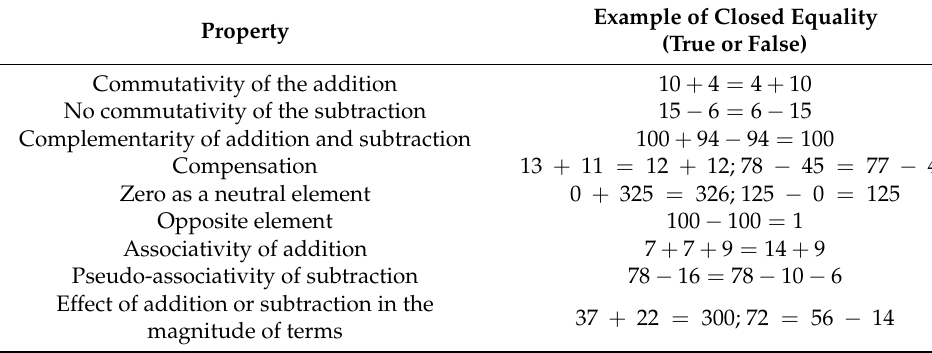
Table 3. Properties considered in the design of